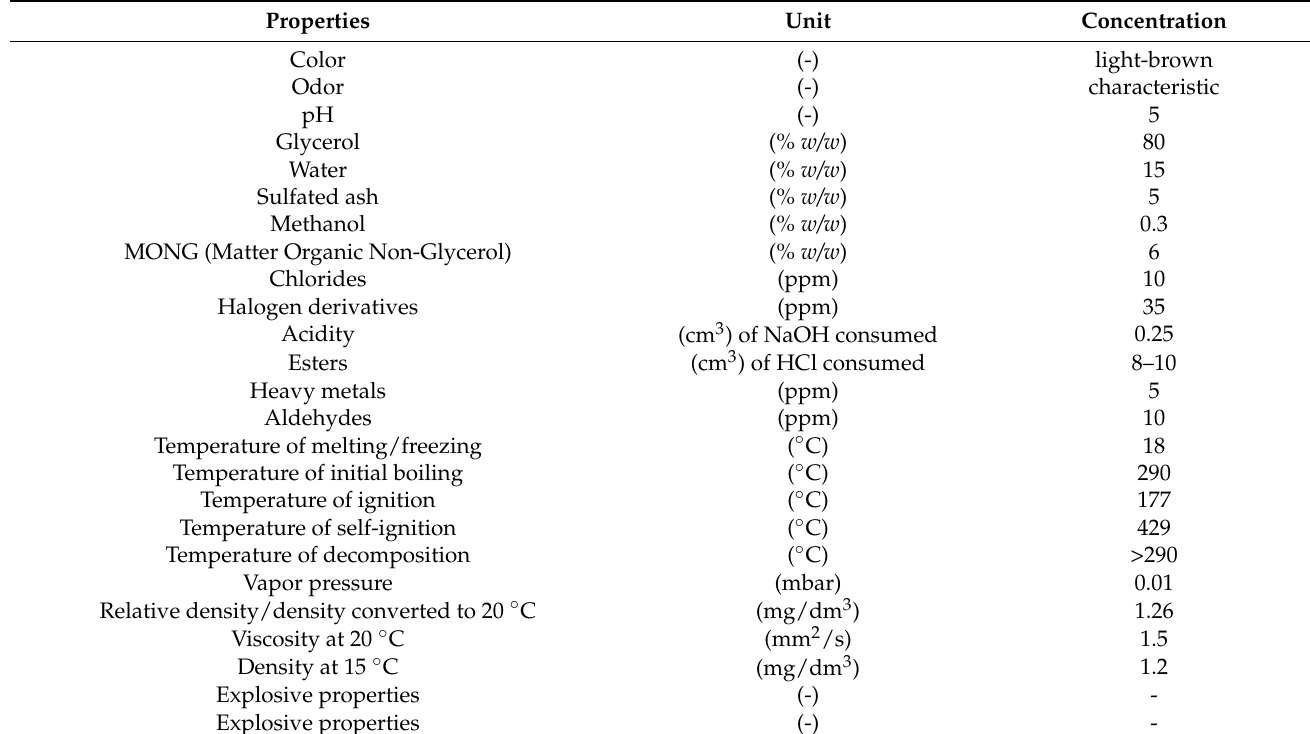
Table 3. Characteristics of crude